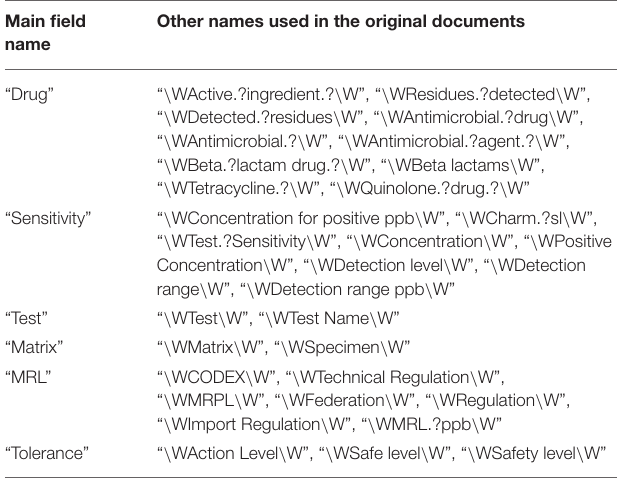
TABLE 1 | Intended keywords to be checked in the extracted tables. Ensemble of keywords to be used for data miner